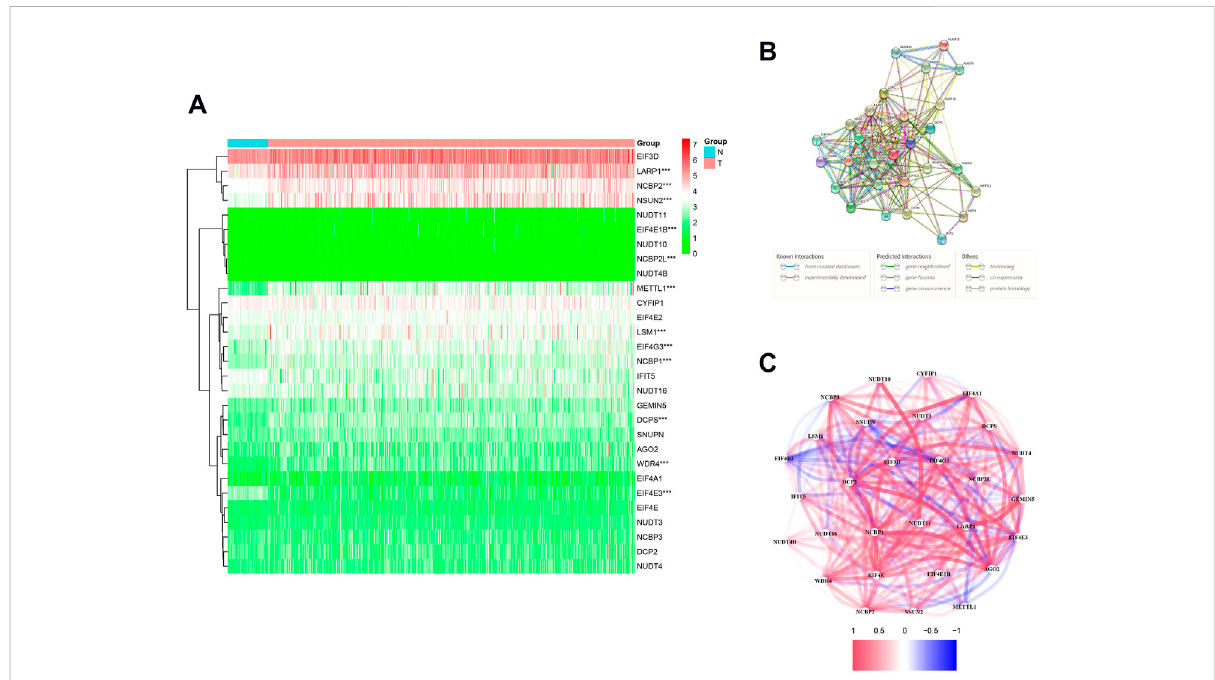
FIGURE 2 Expression and interaction of 29 m7G methylation – related genes. (A) Heatmap (green: low expression; red: high expression) of m7G methylation – related genes between normal (N, bright blue) and tumor (T, pink) tissue in the TCGA LUAD queue. (B) PPI network shows interactions of all m7G methylation – related genes. (C) Correlation network of all m7G methylation – related genes (red: positive relevance; blue: negative relevance. The shade of color re fl ects the strength of the correlation). * p < 0.05, ** p < 0.01; * * * p <